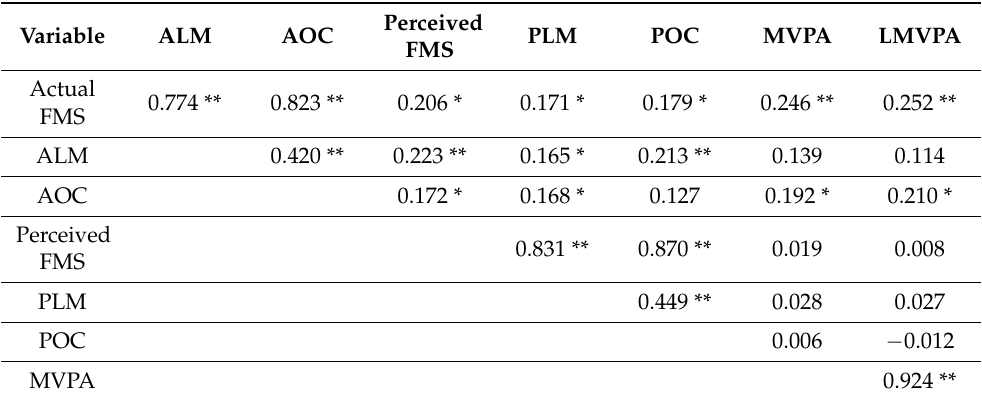
Table 2. Pearson’s bivariate correlations among